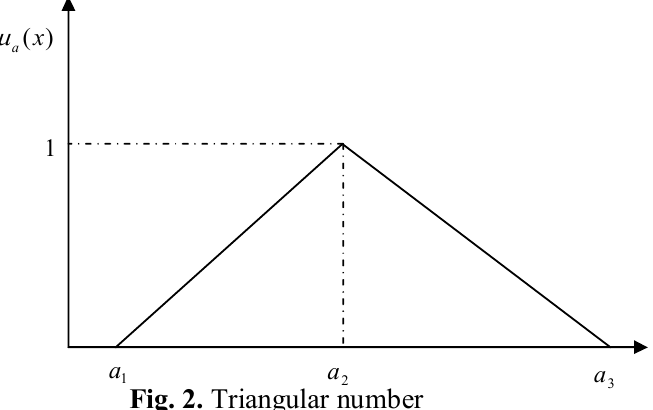
Fig. 2. Triangular number